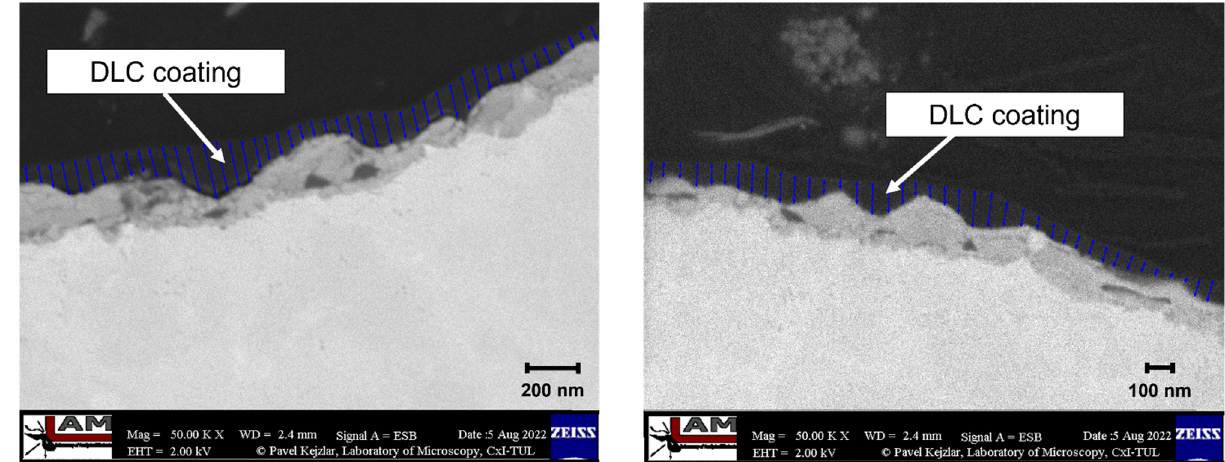
Figure 14. SEM image (ZEISS Ultra Plus) of DLC coating obtained from a